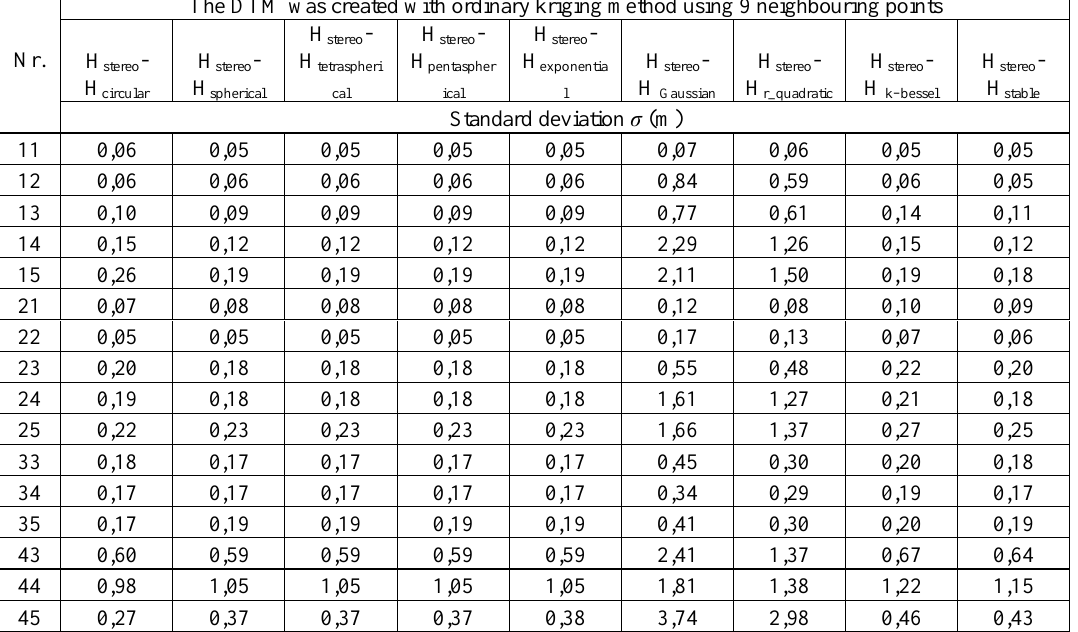
H H H H - - - - stereo stereo stereo stereo H H H H Gaussian r_quadratic k–bessel stable